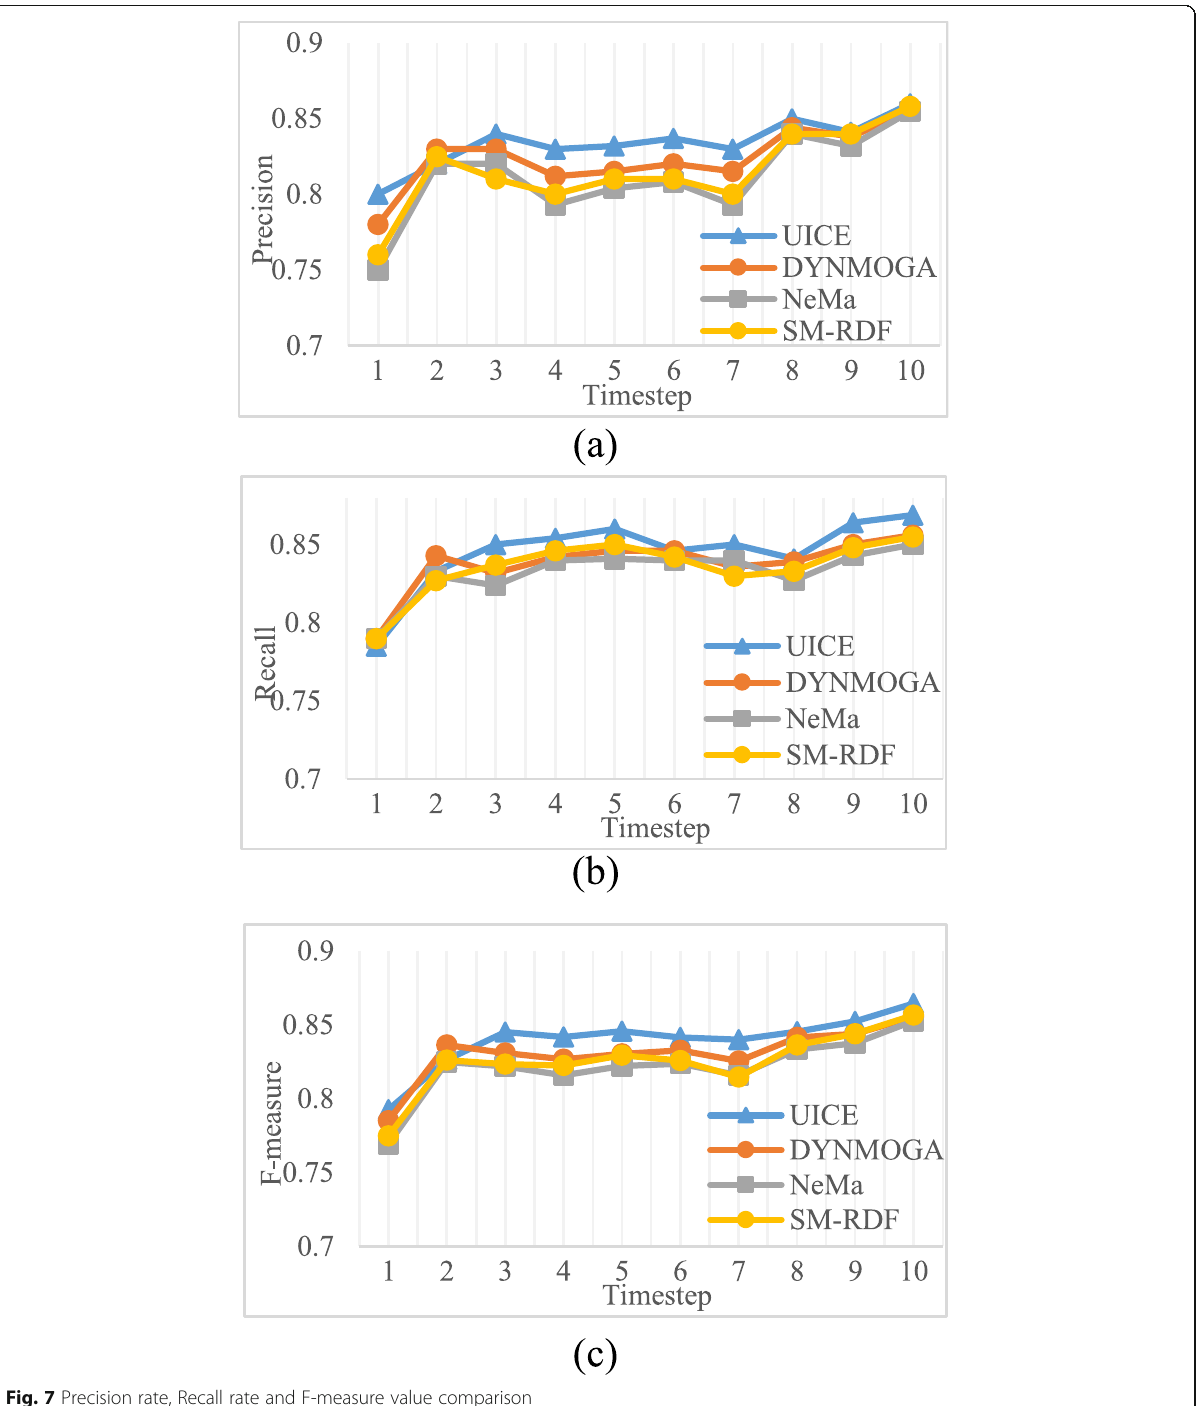
Fig. 7 Precision rate, Recall rate and F-measure value